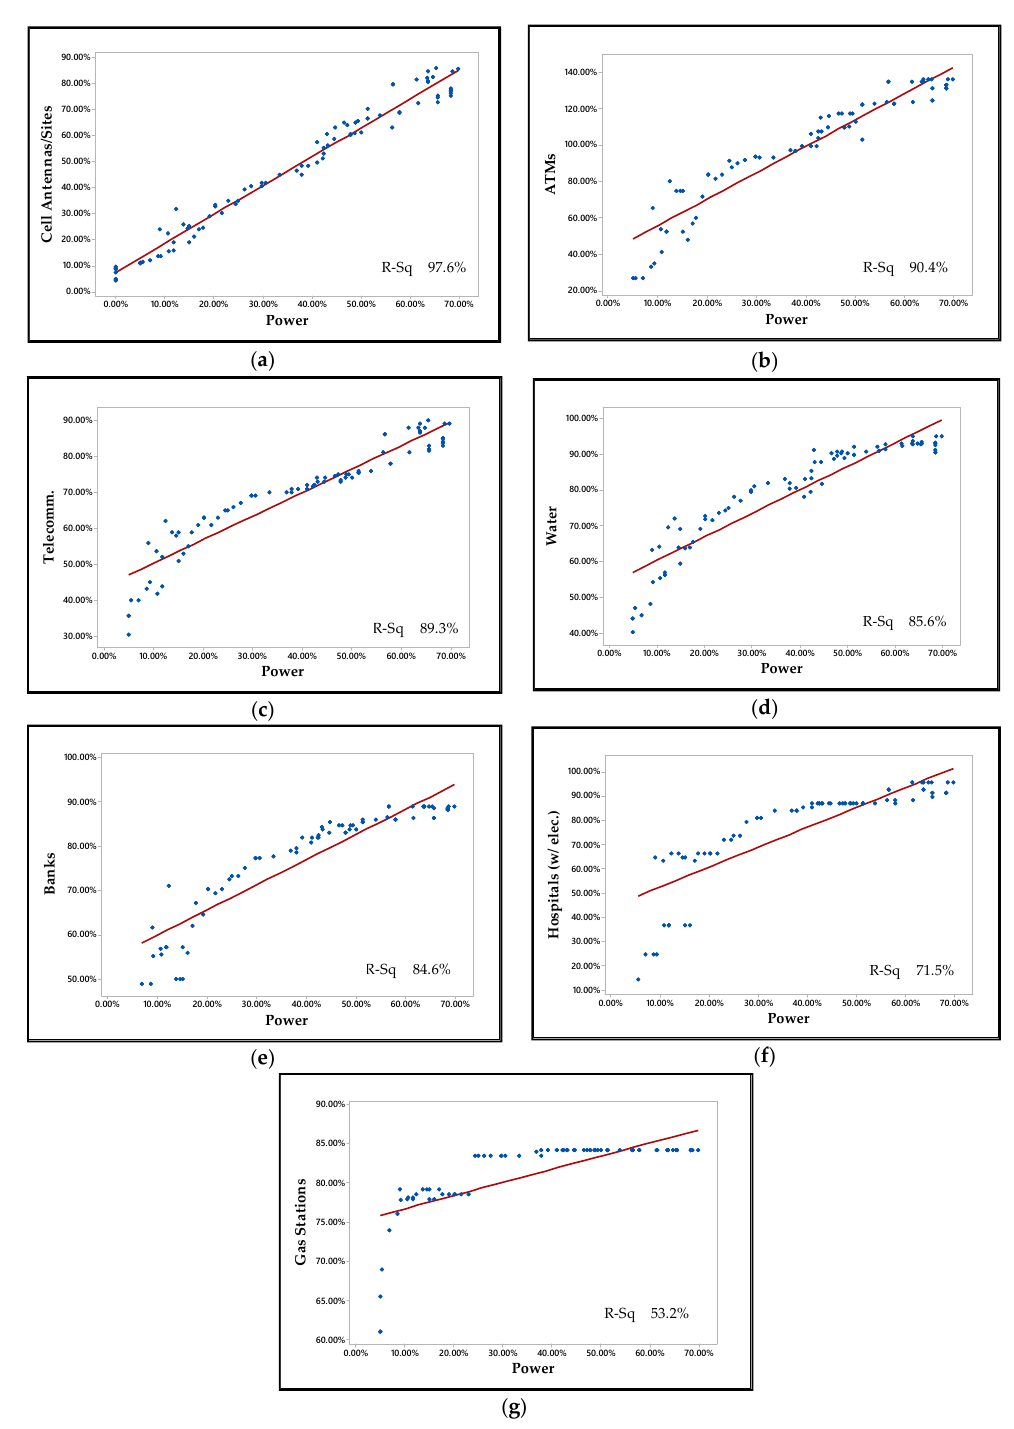
Figure 5. Infrastructure interdependency of ( a ) cell sites; ( b ) ATMs; ( c ) telecommunications; ( d ) potable water; ( e ) banks; ( f ) hospitals with grid electricity; and ( g ) gas station systems, with power systems infrastructure, based on post-disaster recovery patterns after Hurricane